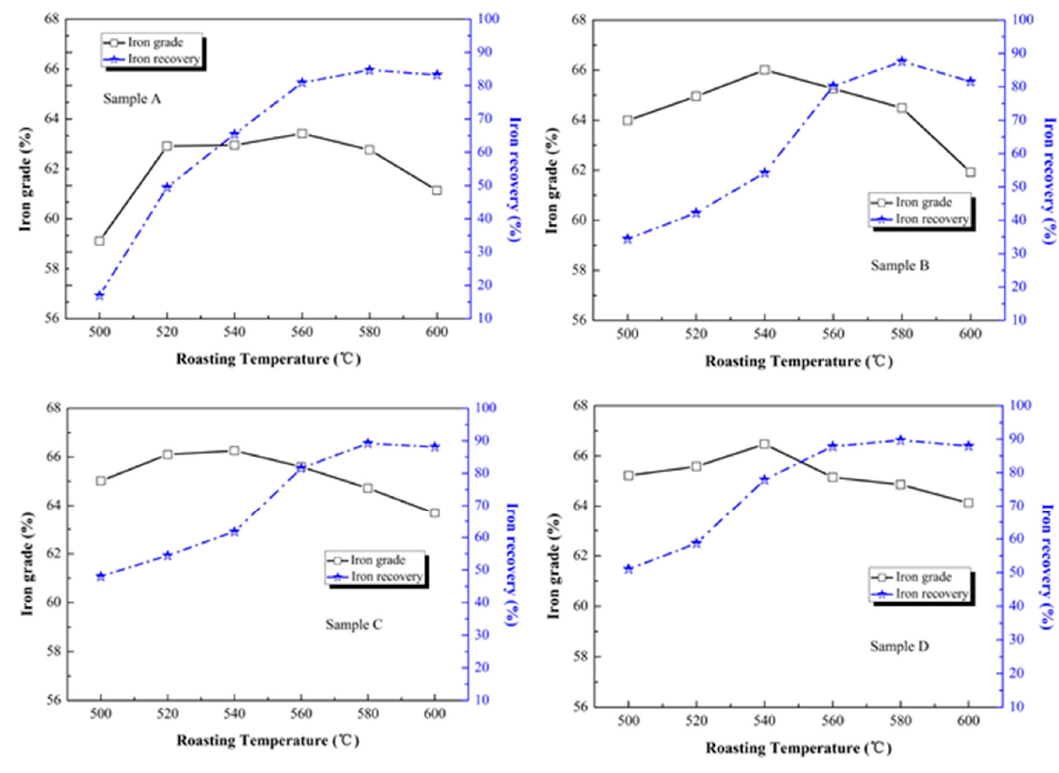
Figure 6. The iron grade and iron recovery of sample A to D with different roasting temperatures. As shown in Figure 6, sample A had a stable iron grade of 62–63% from 520 to 580 ◦ C. The iron grade of sample B to D showed a unimodal form with a roasting temperature of 500 to 600 ◦ C. For sample B to D, the maximum values of iron grade appeared at